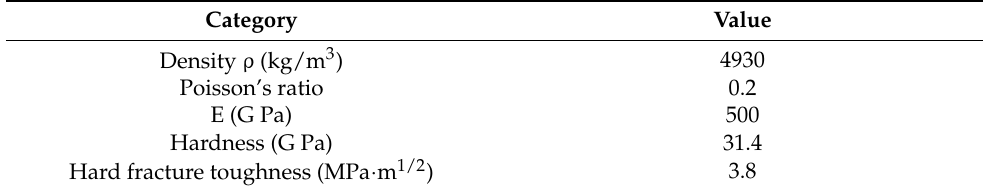
Table 2. Property parameters of TiC material.